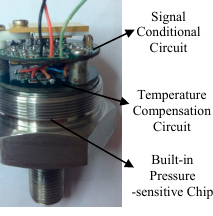
Figure 15. Sensor device pictures.